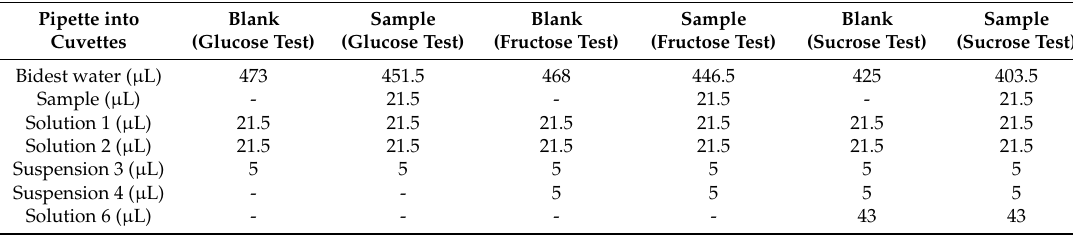
Table 2. Sample composition used in the enzymatic assays.